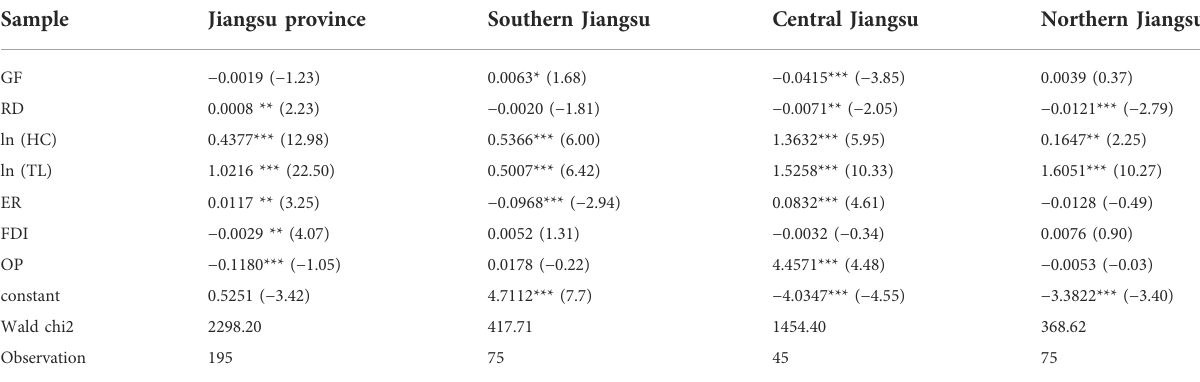
TABLE 6 Regression results of innovation